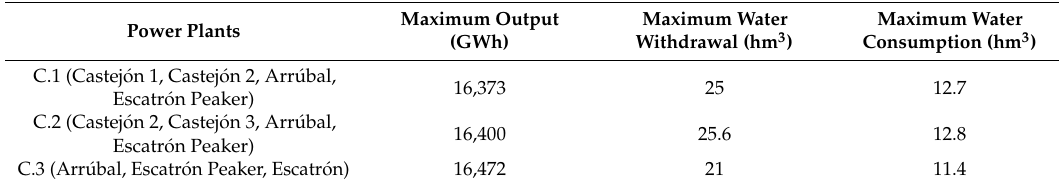
Table 7. Set of combinations in Scenario 3.